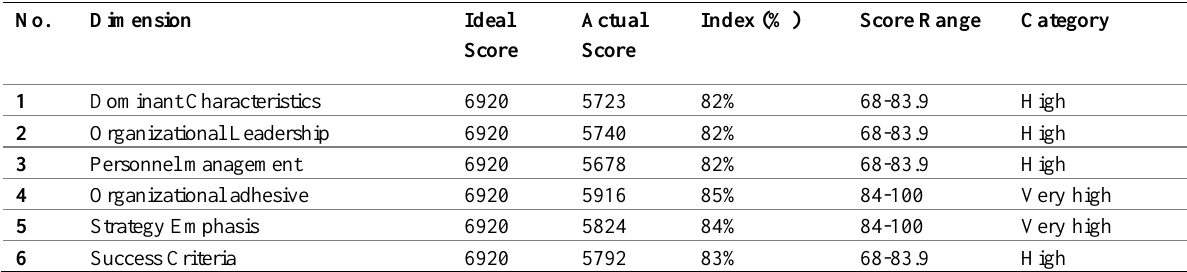
Table 9: Description of Organizational